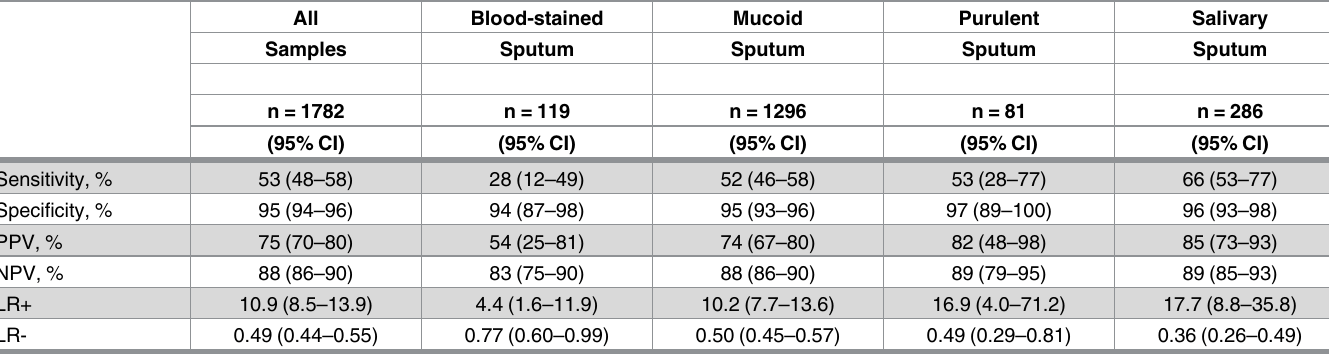
Table 2. Diagnostic performance of GeneXpert among 1782 study participants, stratified by sputum quality characteristics.